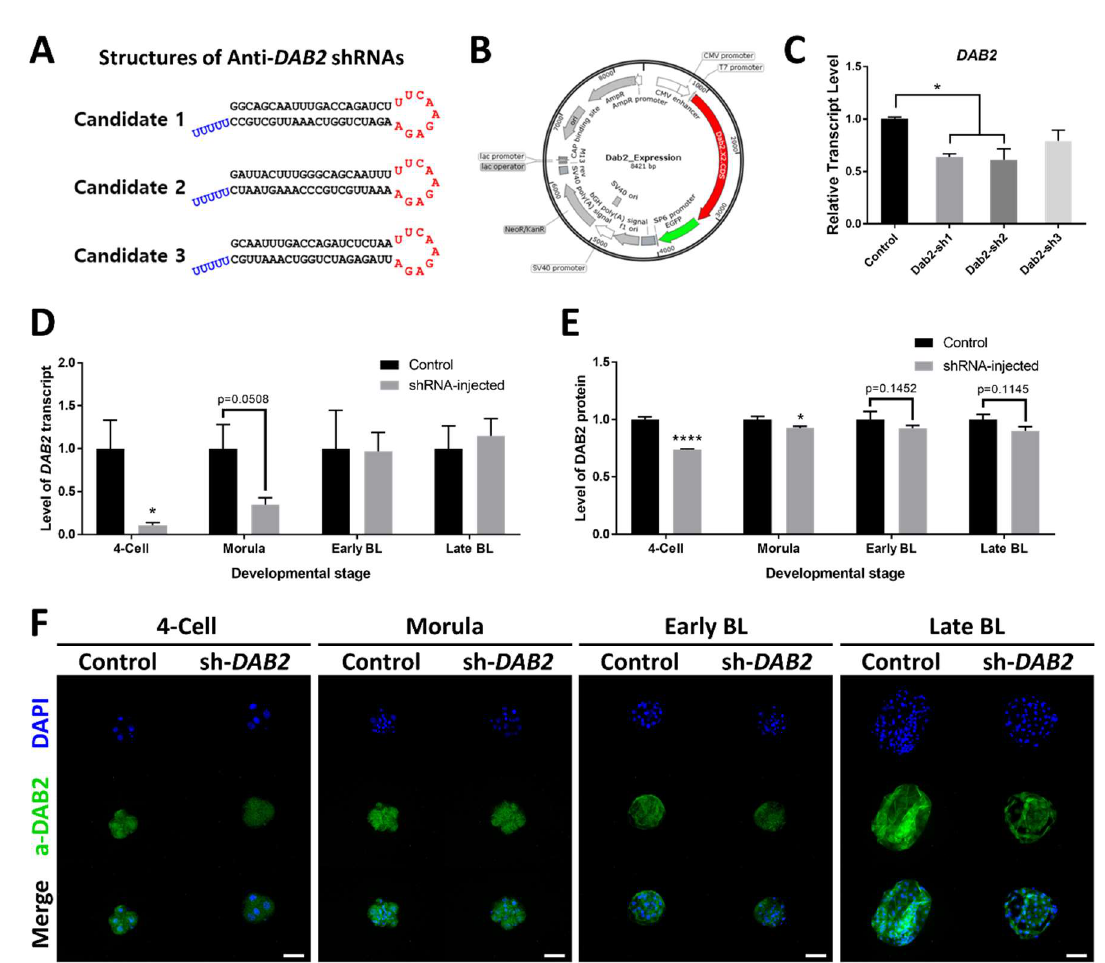
Figure 2. Vector information and verification of shRNA. ( A ) Expected shRNA structures of each candidate. ( B ) Plasmid map of the DAB2 coding region expression vector. ( C ) DAB2 transcript levels in the pFF cells transfected with shRNA vectors. ( D ) Relative level of DAB2 transcript and ( E ) relative level of DAB2 protein in 4-cells, morula, early blastocyst, and late blastocyst stages with or without shRNAs. ( F ) Immunocytochemistry images of DAB2 protein in 4-cells, morula, early blastocyst, and late blastocyst stages with or without shRNAs. * corresponds to significant differences. (*: p < 0.05, ****: p < 0.0001). Size makers correspond to 100 μm.